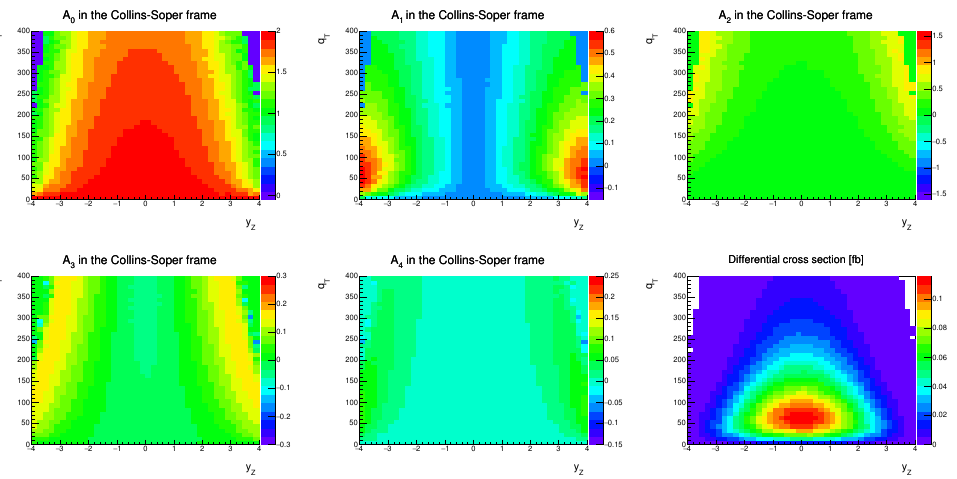
Figure 9 . Angular coe(cid:14)cients A 0 scenario S1 a